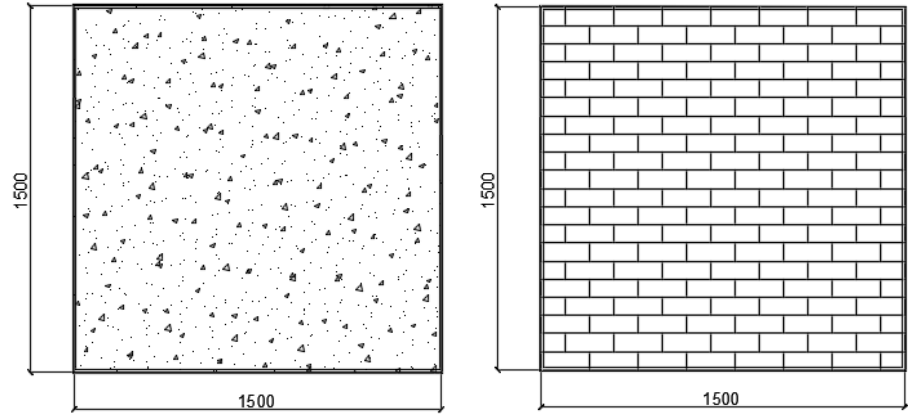
Figure 6. Elevation view of wall specimen (unit: mm).